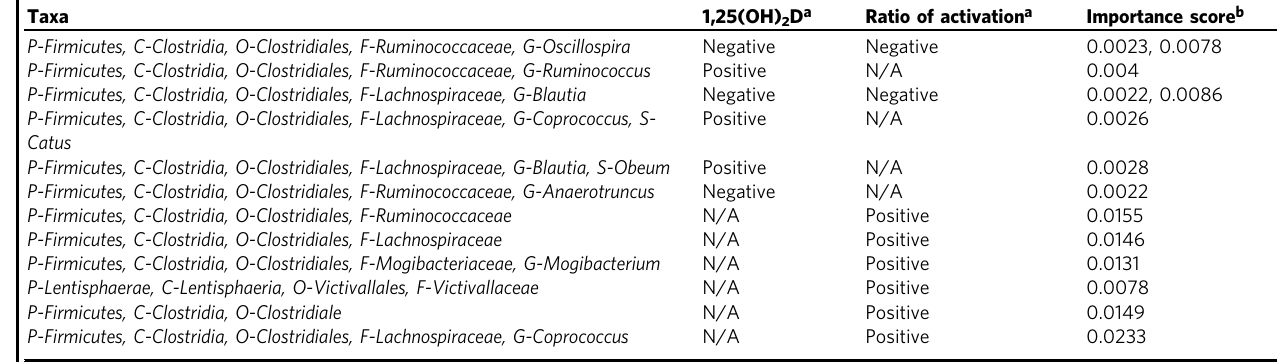
Table 2 sOTUs identi fi ed via random forest as important for classifying 1,25(OH) 2 D, and/or the ratio of activation, ranked by importance